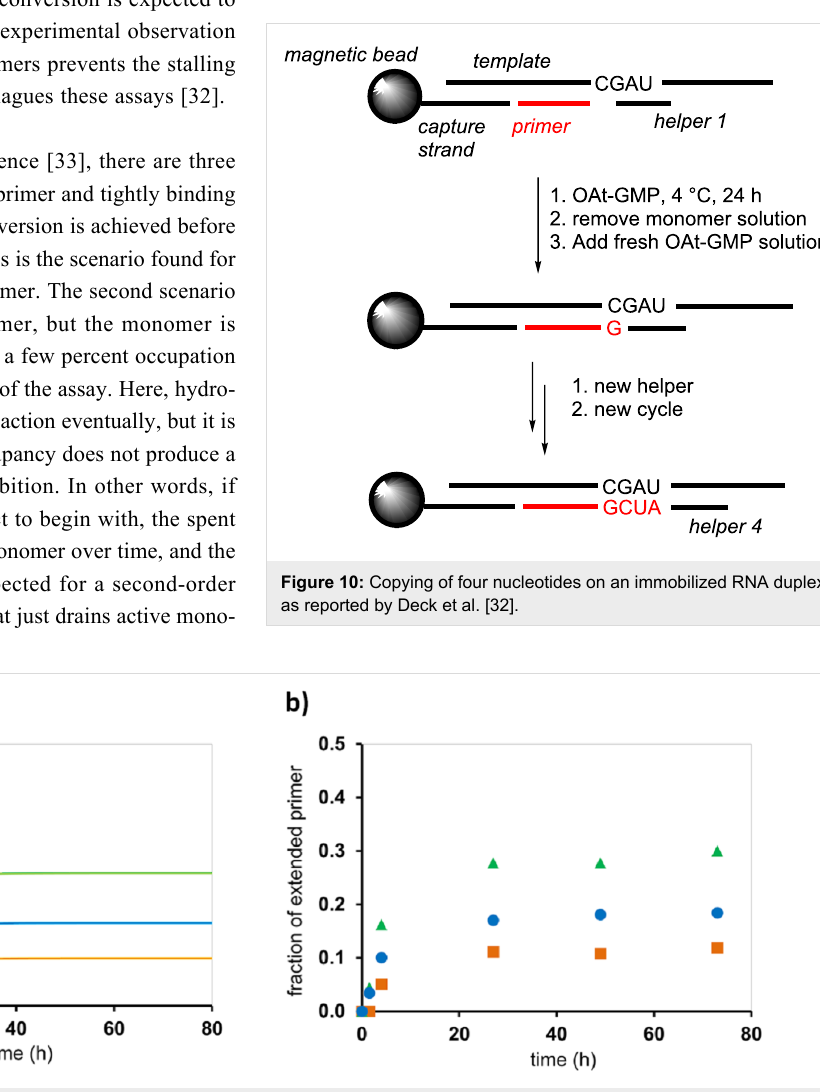
Figure 9: Template-directed primer extension on an RNA template performed with OAt-GMP at 1.8 mM (orange), 3.6 mM (blue), or 7.2 mM (green) initial concentration. a) Conversion over time, as simulated with our quantitative model, using the dissociation constants of both activated and free nucleotide, and rate constants for hydrolysis and chemical step. The broken black line is the hypothetical conversion of the primer without hydrolysis of monomer and the resulting inhibition; b) Corresponding experimental data, acquired in primer extension assays at 20 °C in buffer (200 mM HEPES, 400 mM NaCl, 80 mM MgCl 2 , at pH 8.9) at 36 µM primer–template (5'-UAUGCUGG-3' – 3'-CACCCACCACAUACGACCCAAGCACAC-5'); see refer- ence [34] for further details.